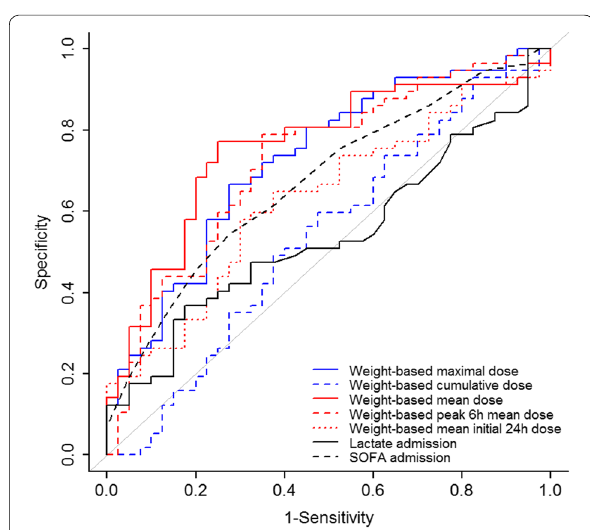
Fig. 3 Receiver operating characteristic curves for vasopressor vari‑ ables, SOFA, lactate and